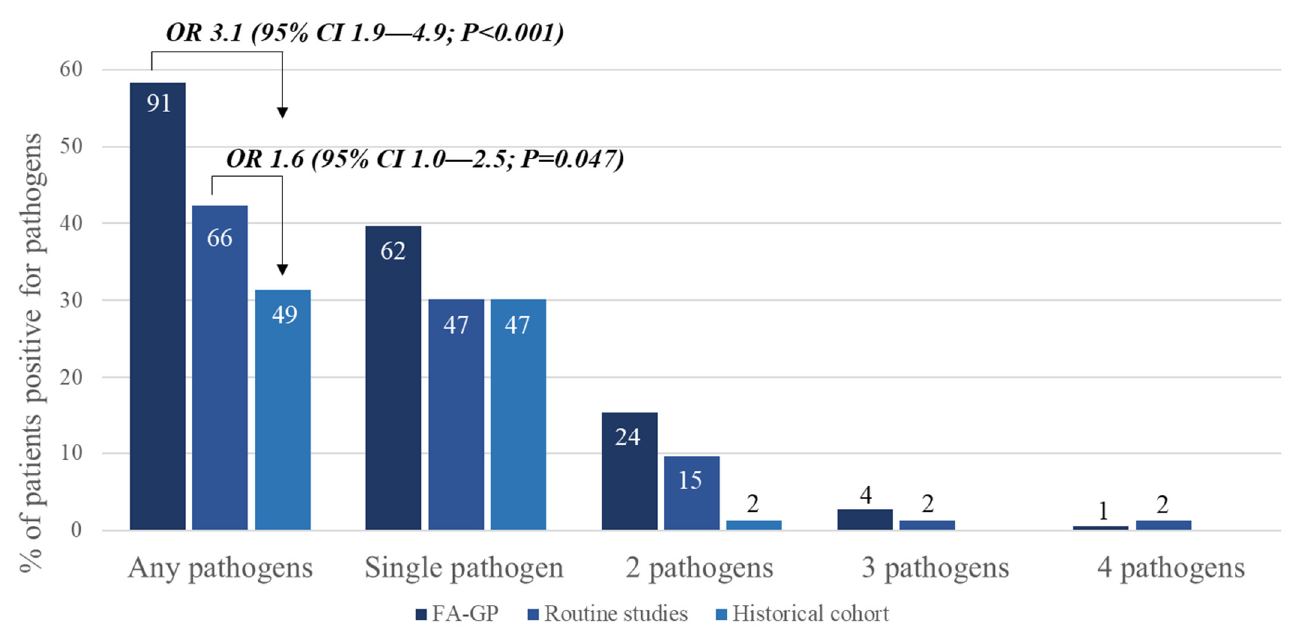
Figure 2. Pathogen positivity rate and number in the prospective and historical cohort. The odds ratio for a pathogen being detected in patients with acute diarrhea was 3.1 (95% confidence interval (CI) 1.9–4.9, p < 0.001) times higher in those with stool studies done by the FA-GP compared to those in the historical cohort. Numbers within the bars in the graph represent the actual number s of pathogens detected.